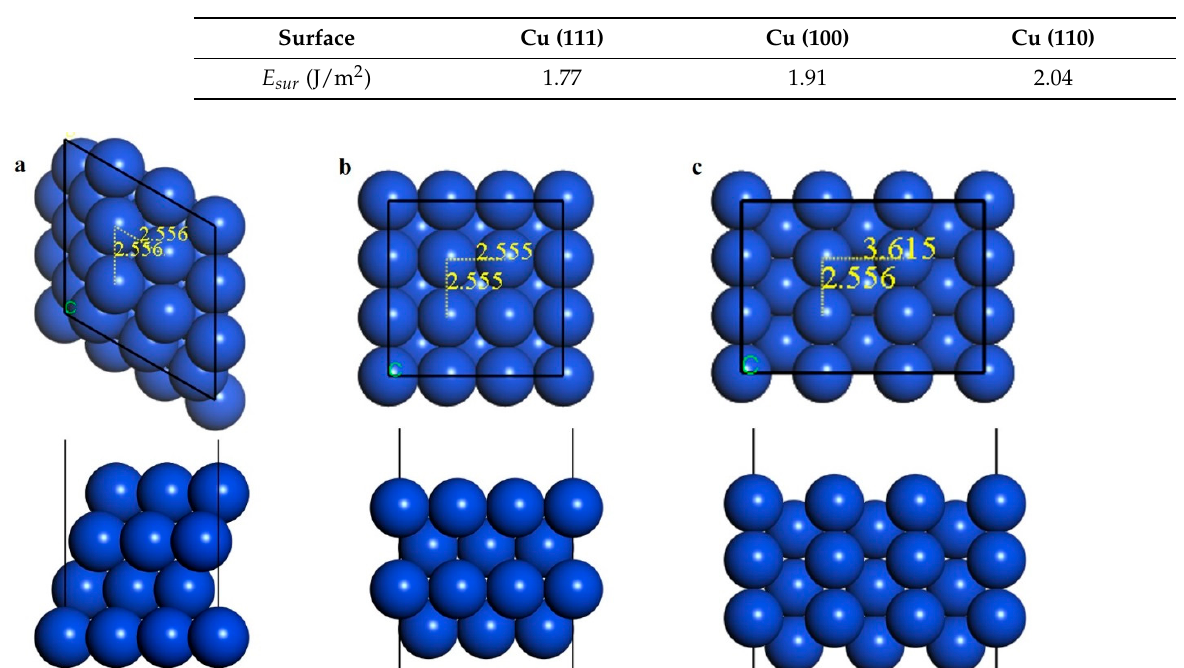
Figure 1. Top view and side view of the optimized structures of ( a ) Cu (111), ( b ) Cu (100) and ( c ) Cu (110), respectively. (110),